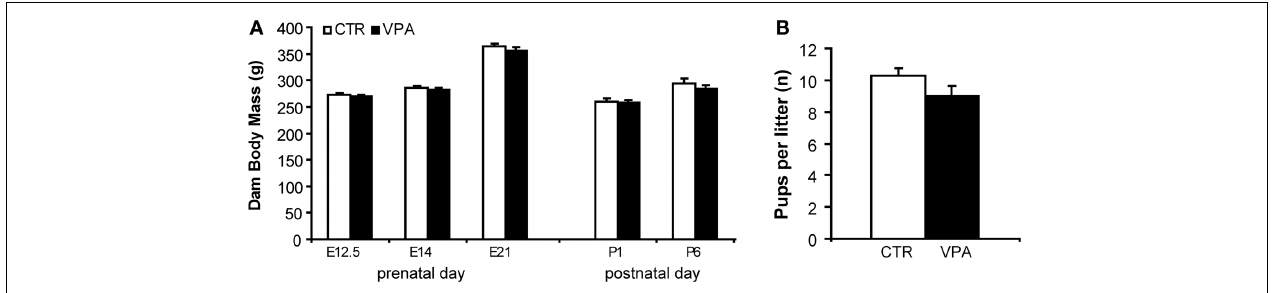
FIGURE 2 | Pregnancy outcome in control (CTR) and VPA 500mg/kg treated dams. (A) Dam body mass (grams) during embryonic days 12.5, 14, 21 (prenatal) and postnatal days 1 and 6, suffer no significant effect of